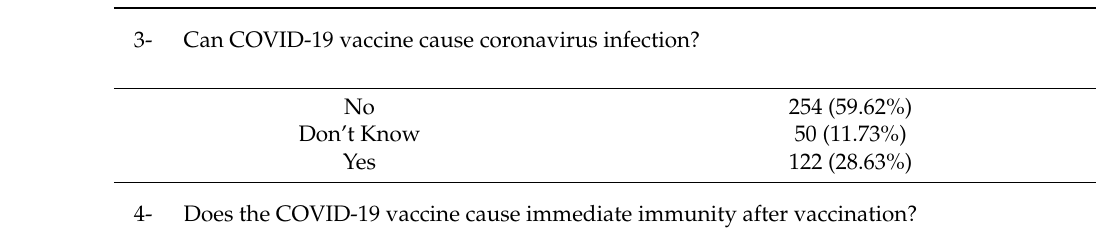
Table 5. Awareness domains of COVID-19